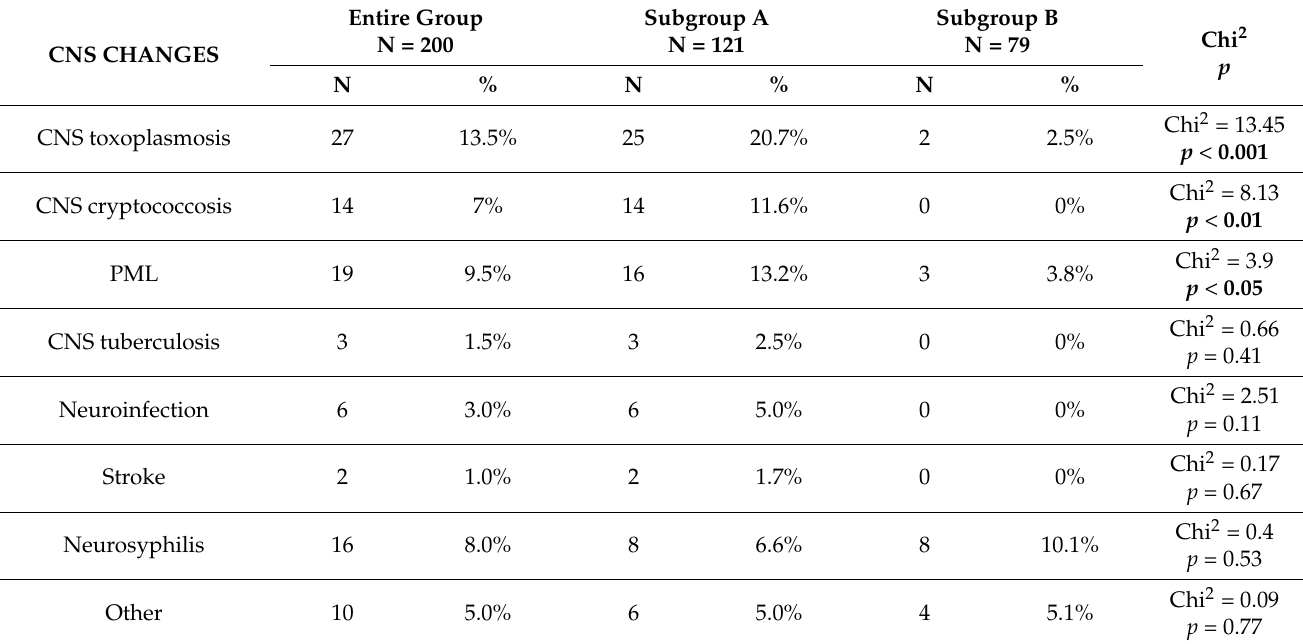
Table 6. CNS diseases in specific subgroups of HIV-infected